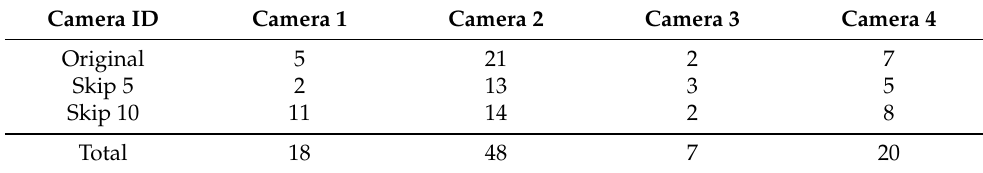
Table 1. Incorrect ID switching in a four-camera network with three different skip